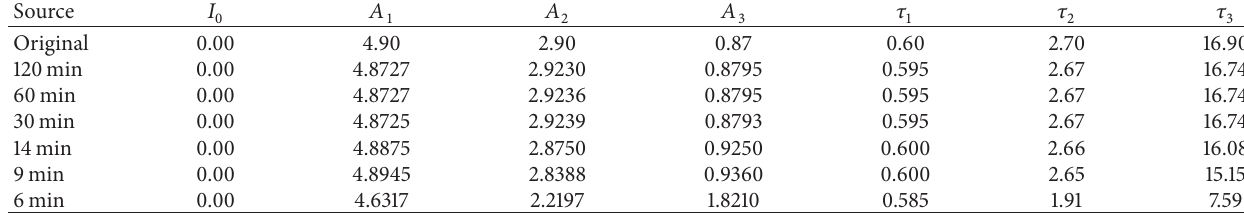
Table 3: Simulated by using equations without the 𝐼 0 term.